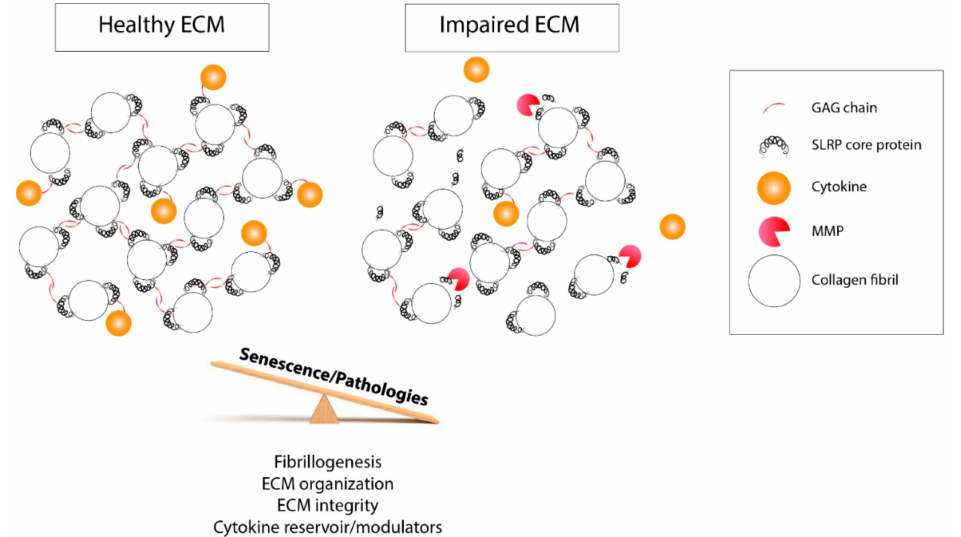
Figure 4. Schematic representation of the biological functions of post-translational modifications impacted by aging and pathology development. On the left panel, GAG side chains and the tyrosine sulfate-rich domain of SLRPs help to maintain the ECM biomechanical properties and the fibrillogenesis and organize the collagen fibrils. They regulate the cell response and their homeostasis through their interaction with cytokines and modulate their accessibility. On the right panel, following an imbalanced control of the post-translational events and MMP-driven degradation, the ECM biological properties are disturbed, which impedes the bioavaibility of cytokines that are free to leave the ECM. This latter case can be prompted by a disease condition or the aging